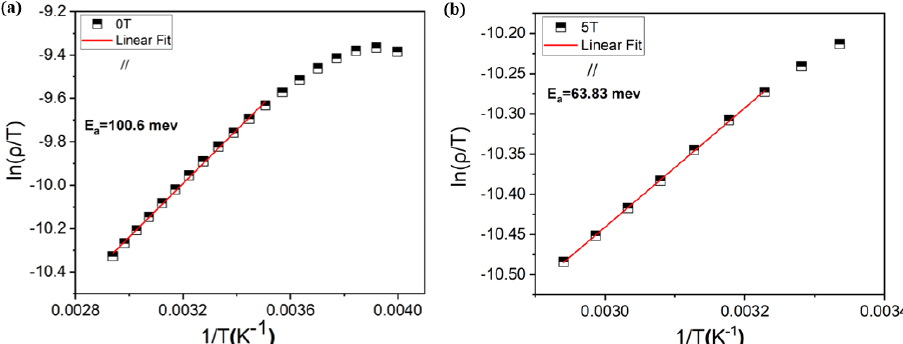
Figure 5. Fitting plots of the resistivity data of LBMTO-5 thin film in the low temperature ferromagnetic metallic state by using Equation (1) for a zero-field ( a ) and under 5 T induction ( b ), in the parallel geometry.